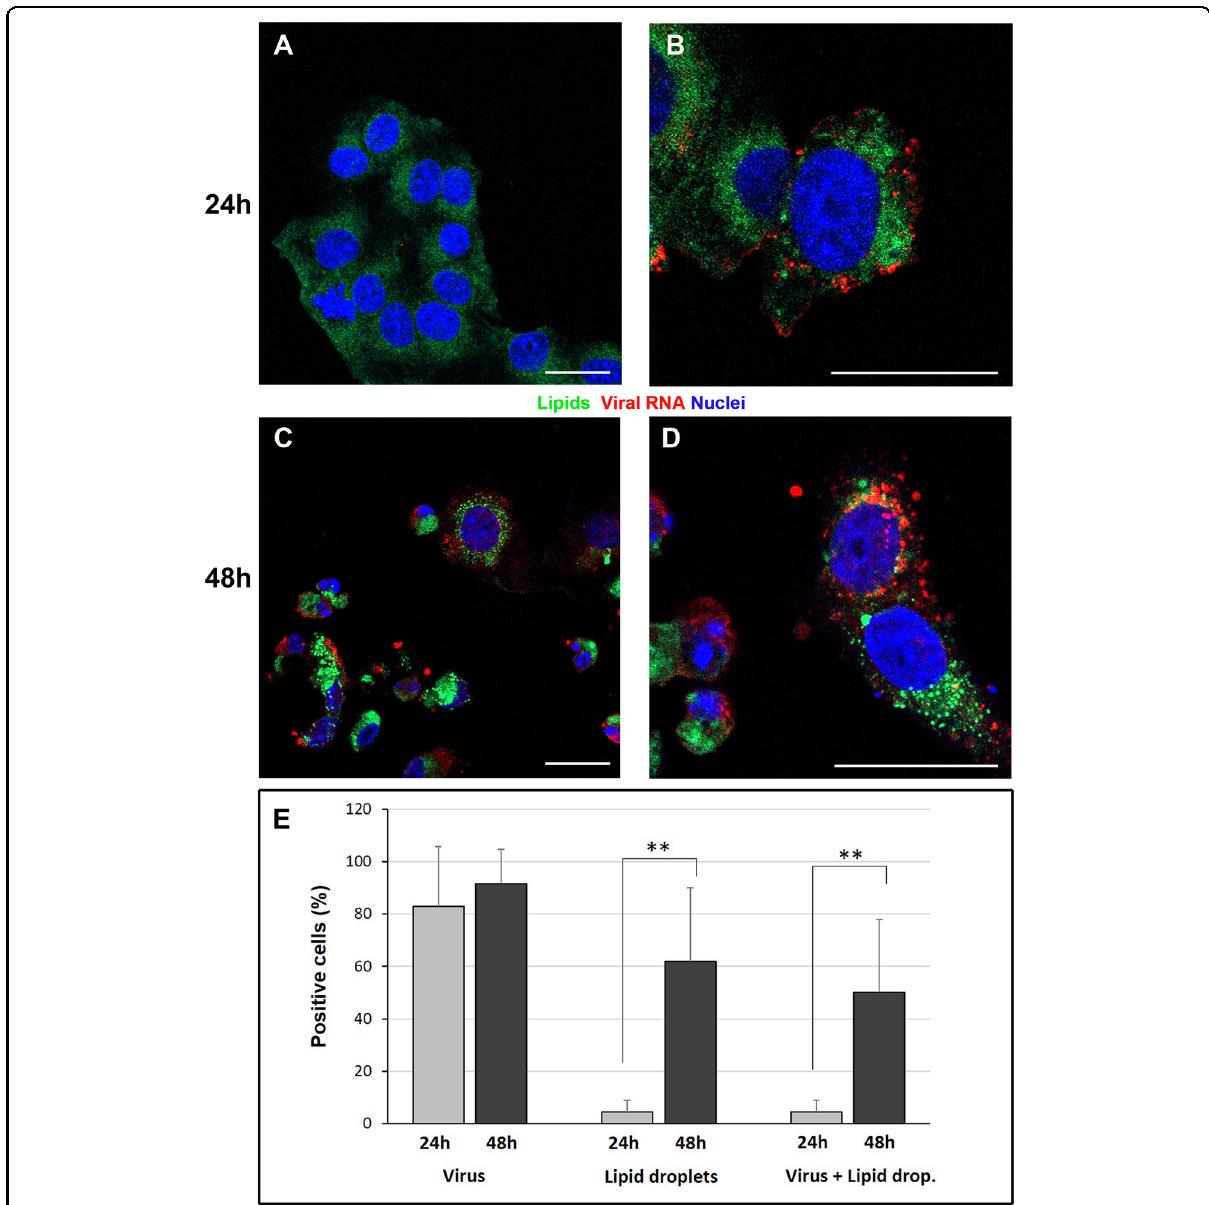
Fig. 4 Confocal microscopy of SARS-CoV-2-infected Vero cells. Immuno fl uorescence dual-labeling detection of viral dsRNA and lipid droplets. A Control cells, display absence of dsRNA signal and diffuse staining with lipophilic dye. B At 24 h post infection some cells showing viral RNA (red) also present lipid droplets (green dots) in the cytoplasm. C , D Numerous lipid droplets are visible in the cell cytoplasms (green dots) of cells 48 h post infection. E The graph shows the percentage of cells displaying viral RNA, lipid droplets staining or both labeling at 24 h and 48 h post infection. Data are mean ± SD from at least three independent experiments, and each experiment included duplicate samples. Statistically signi fi cant difference is showed (** p < 0.01). dsRNA (red); lipid droplets (green). Nuclei are stained blue (DAPI). Scale bars: A – D = 5 μ